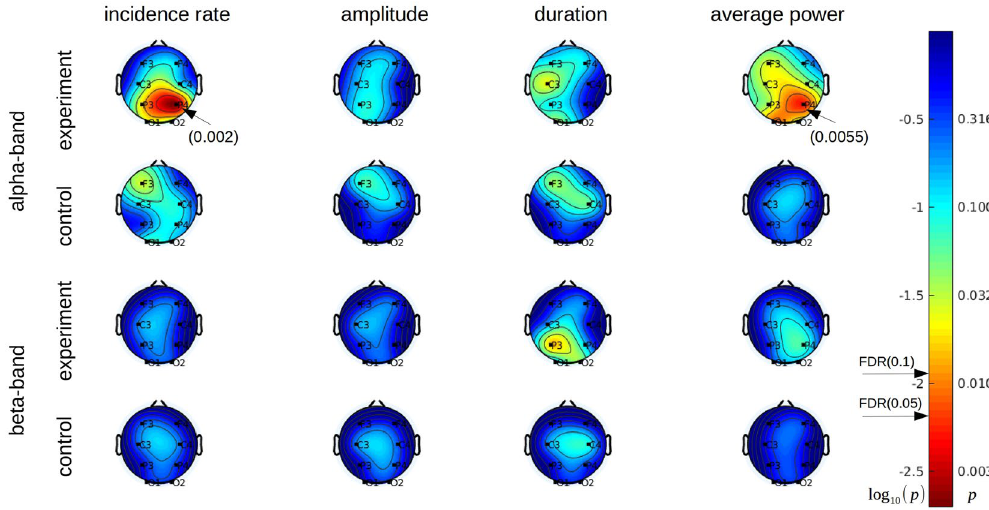
Figure 4. Statistical analysis of Q α ( t ) waveform morphology in terms of the incidence rate of alpha spindles (first column), their duration (second column), amplitude (third column) and average power (fourth column). The electrodes exhibiting significant changes are pointed by the arrows with the corresponding p –values specified in brackets. A linear colormap encodes the log10 p -values obtained from the permutation test of no difference between days 1 and 2. Non-logarithmic p -values are also shown on the outer side of the colorbar. Beta band changes are included in the analysis as a control for frequency band specificity. Significant differences that pass the FDR (0.1) correction for multiple comparisons are observed only for the spindles incidence rate parameter at P4 (p = 0.002) and for the average power at the same electrode (p = 0.0055). These differences correspond to a greater mean value observed on day 2, as compared to day 1. Note that changes in the incidence rate parameter are more spatially specific and better correspond to the goal of neurofeedback training of enhancing alpha rhythm power at P4 than the average power changes (top row, rightmost column).